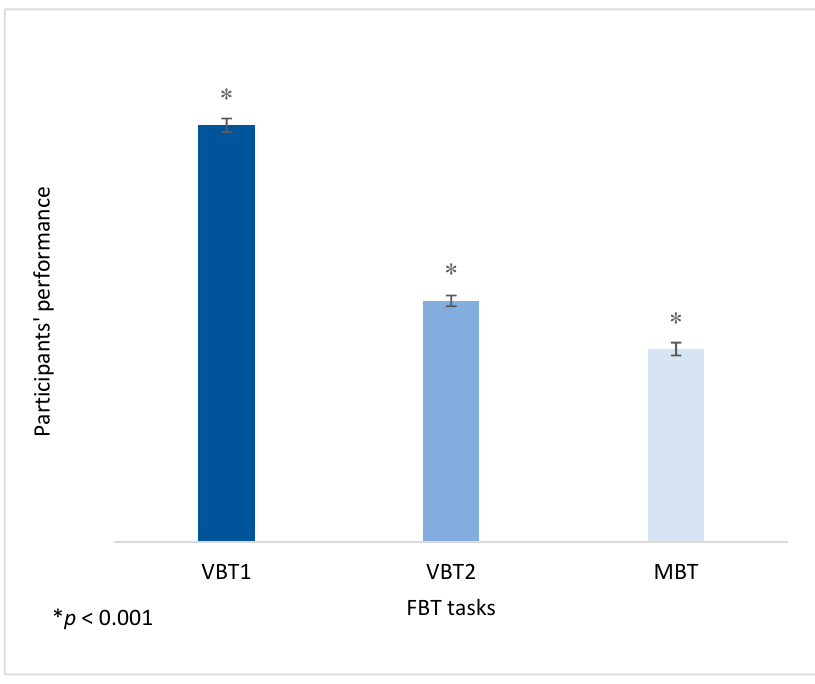
Figure 4. Participants’ performance in the three tasks of FBT.